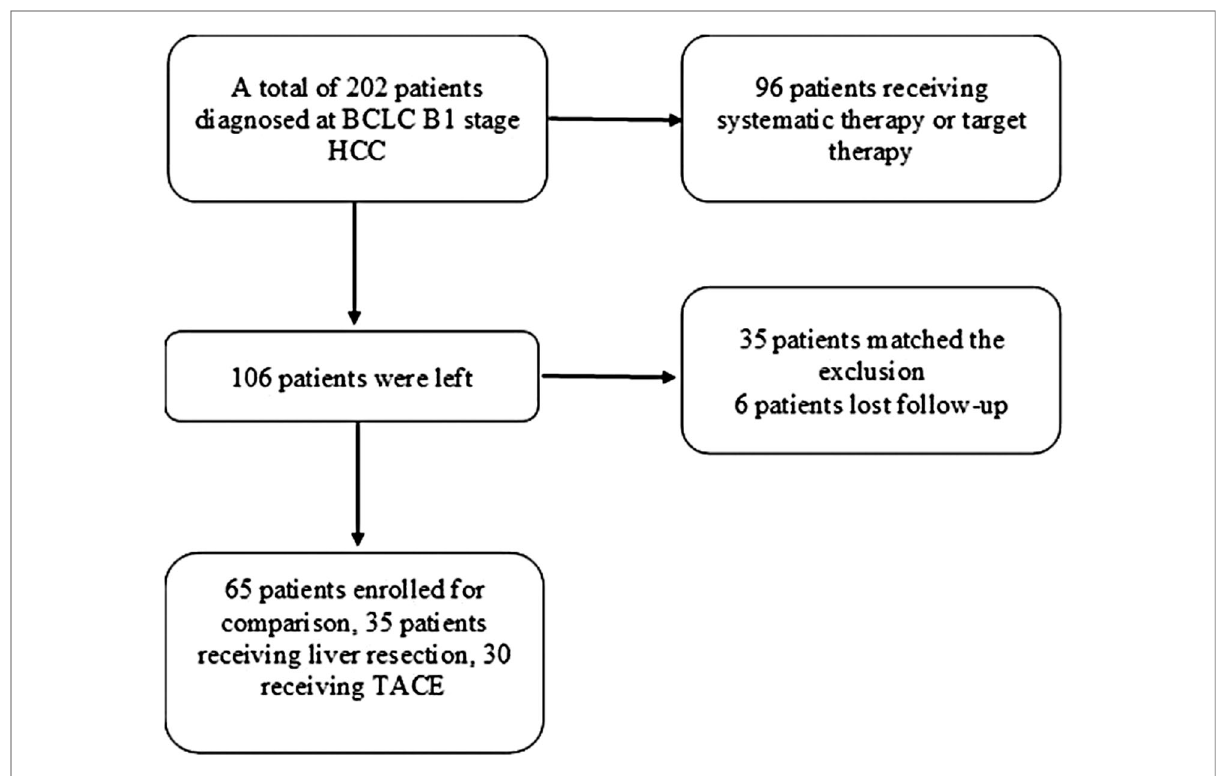
FIGURE 1 Flow chart of patient